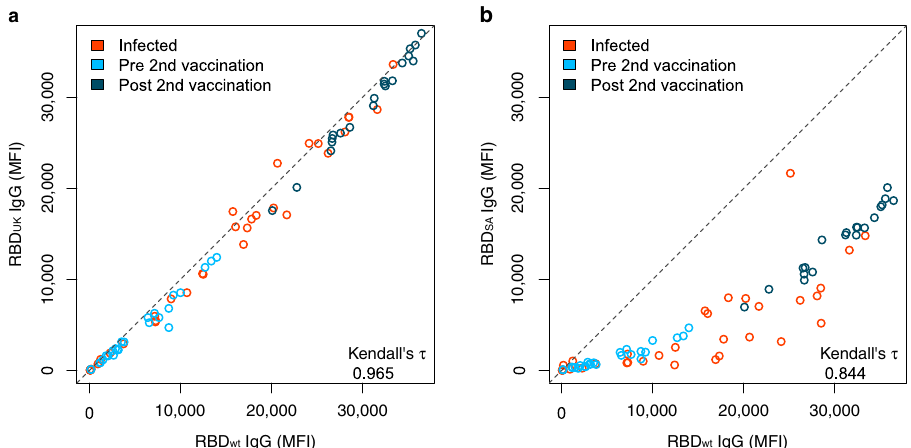
Fig. 3 South African RBD mutant has a reduced response compared to UK RBD mutant. UK ( a ) and South African (SA) RBD mutants ( b ) have differing effects upon antibody binding. RBD mutant antigens were generated and added to MULTICOV-AB to measure the immune response towards them in sera from vaccinated pre-second dose (light blue, n = 25), post second dose (dark blue, n = 20), and infected (red, n = 35) individuals, compared to the wild- type (wt) RBD. A linear curve ( y = x ) is shown as a dashed gray line to indicate an identical response between wild-type and mutant. Kendall ’ s tau was calculated to measure the ordinal association between the mutant and wild-type. Source data are provided as a Source Data fi le.